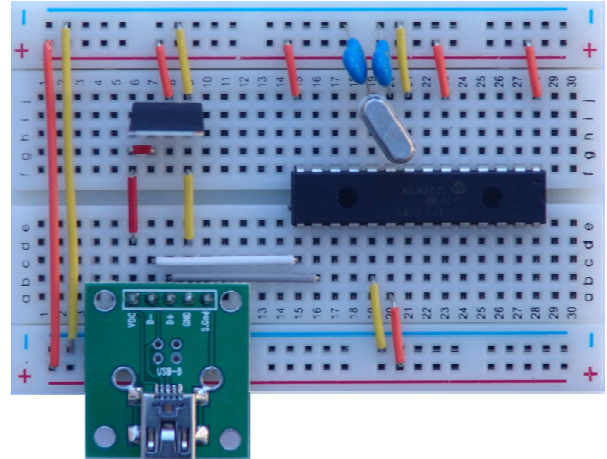
Figure 1. Example of using the SimpleDAQ chip on the breadboard.